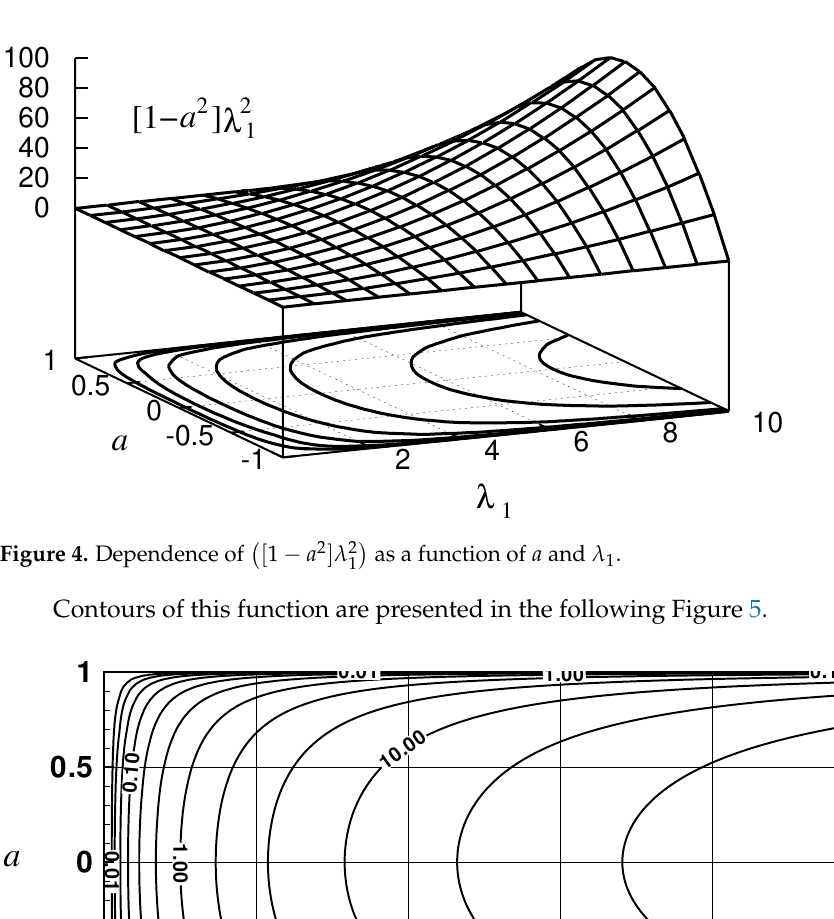
Figure 5. Contours of